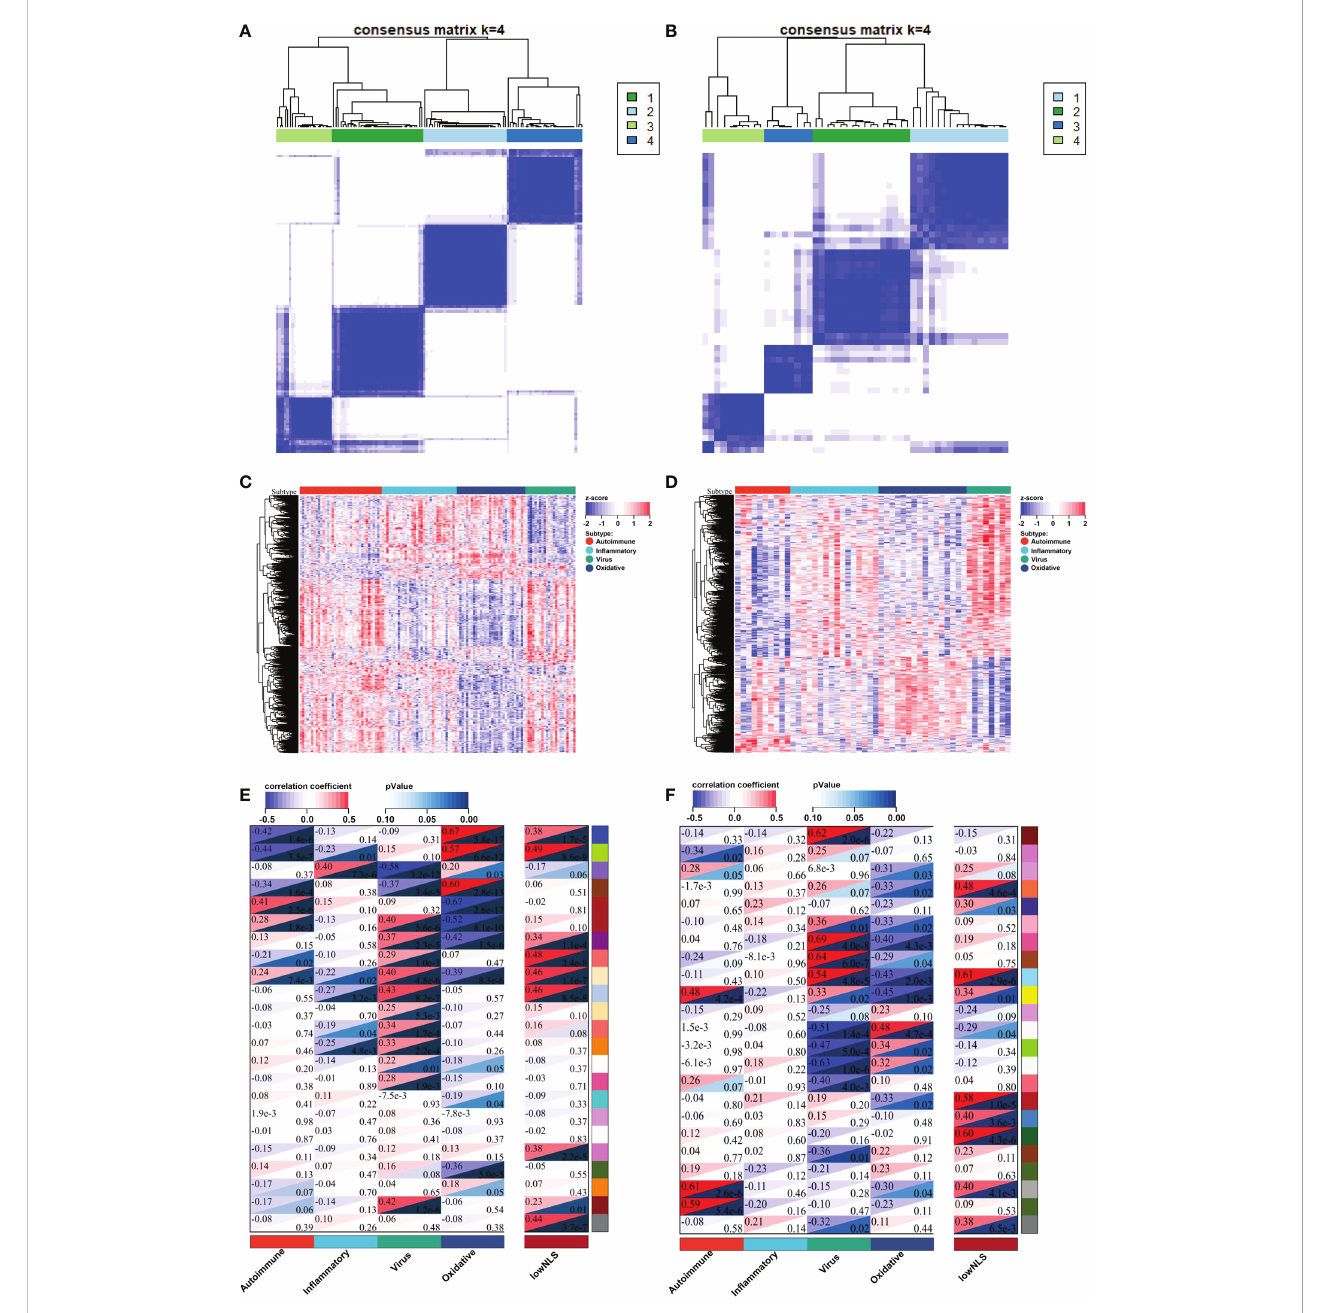
FIGURE 2 Identify four molecular subtypes of patients with BA in the training and validation datasets. By applying SNF-CC, training set (A) and validation set (B) were clustered into four distinct subtypes. GSVA similarly classi fi ed the samples into four subtypes in training set (C) and validation set (D) . Each subtype in training set (E) and validation set (F) was involved with different gene modules of WGCNA. BA, biliary atresia; NLS, natural liver survival; SNF-CC, Similarity Network Fusion and Consensus clustering; GSVA, Gene set variation analysis; WGCNA, Weighted Gene Co-expression Network